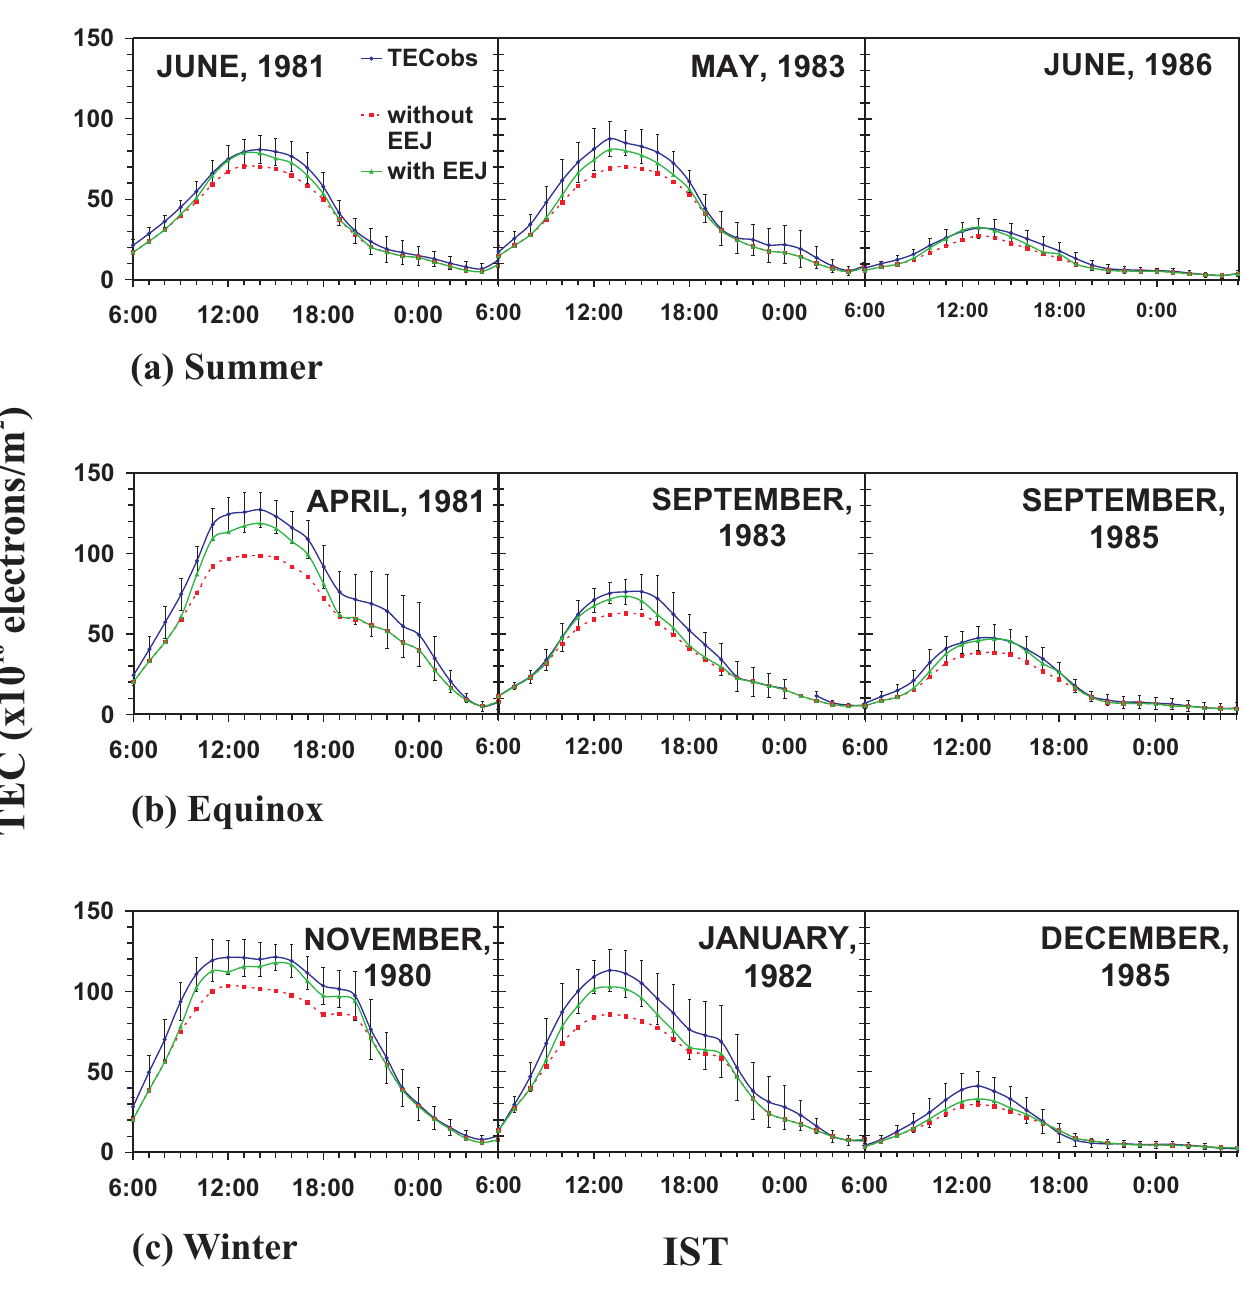
Figure. 6 Fig. 6. Plots of observed monthly mean diurnal TEC (solid blue lines with vertical bars), calculated TEC without (red dotted lines) and with (solid green lines) the effect of EEJ for summer solstitial months (a) , equinoctial months (b) and winter solstitial months (c) of the years as mentioned. Vertical bars represent standard deviations of the monthly mean observed